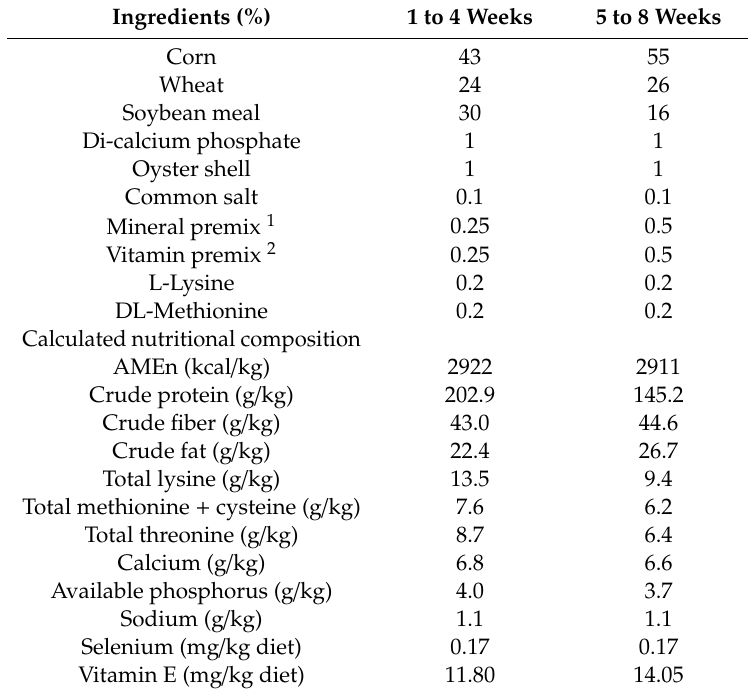
Table 1. Composition and calculated nutritional levels of the control